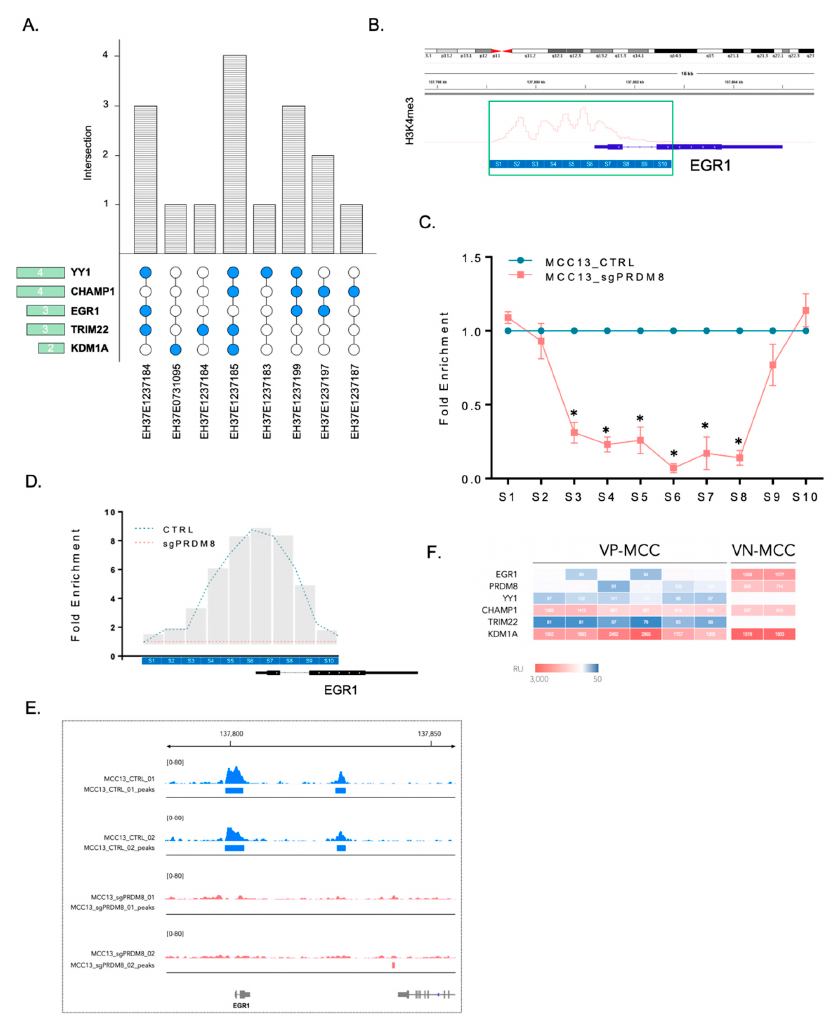
Figure 5. ( A ) UpSetR plot showing intersection of transcription factors (TFs) with high binding affinity to PRDM8 from the chromatin immunoprecipitation sequencing (ChIP-seq) data of Encyclopedia of DNA Elements (ENCODE) database. Sample IDs including both fibroblasts and keratinocytes as cells of origin in MCC are indicated in lower part of the plot. Blue circles show samples with high binding affinity of TF-PRDM8 and white circles are samples with no TF-PRDM8 binding. Gray bars show the number of top-scored TFs that bind to PRDM8. Aggregate number of samples for each row is shown in the green horizontal bar next to each TF. ( B ) Integrative Gene Viewer (IGV) browser snippet of H3K4me3 ChIP-seq track of the MCC cells, showing promoter binding site around the transcriptional start site (TSS) of early growth response protein 1 (EGR1). Chromosome ideogram and coordinates are shown in the upper panel. Binding site DNA sequence was split into ≈ 400bp sites (S 1 -S 10 ) for further enrichment analysis using primers specific to each site. ( C ) PRDM8-depleted and control cells (MCC13_sgPRDM8 and MCC13_CTRL) underwent PRDM8 chromatin immunoprecipitation followed by qPCR (ChIP-qPCR) for enrichment at each binding site. PRDM8-depleted cells showed significantly lower binding enrichment in bins S 3 to S 8 compared to control cells. ( D ) Plotting ChIP peak signals using sequential ChIP-qPCR data from EGR1 binding site (S 1 -S 10 ). Signal intensity was normalized to 1 in all the PRDM8-depleted bins. Projected peak height for control cells was calculated for every bin and smoothed spline fit was plotted. This plot showed significant decrease in normalized binding enrichment in PRDM8-depleted cells compared to the control cells. ( E ) IGV snapshot of the PRDM8 ChIP-seq performed using KO and control MCC-13 cells (two replicates) illustrating PRDM8 binding at EGR1 region. ( F ) EGR1 and PRDM8 expression levels in VN- vs. VP-MCC indicated higher levels of EGR1 and PRDM8 co-expression in VN-MCC compared to VP-MCC